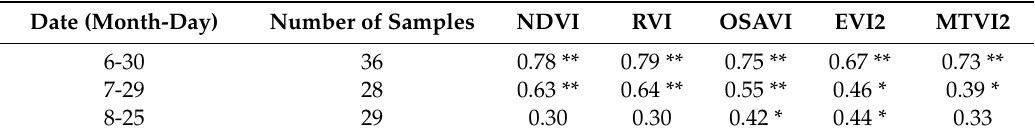
Table 1. The R values between vegetation indices and field